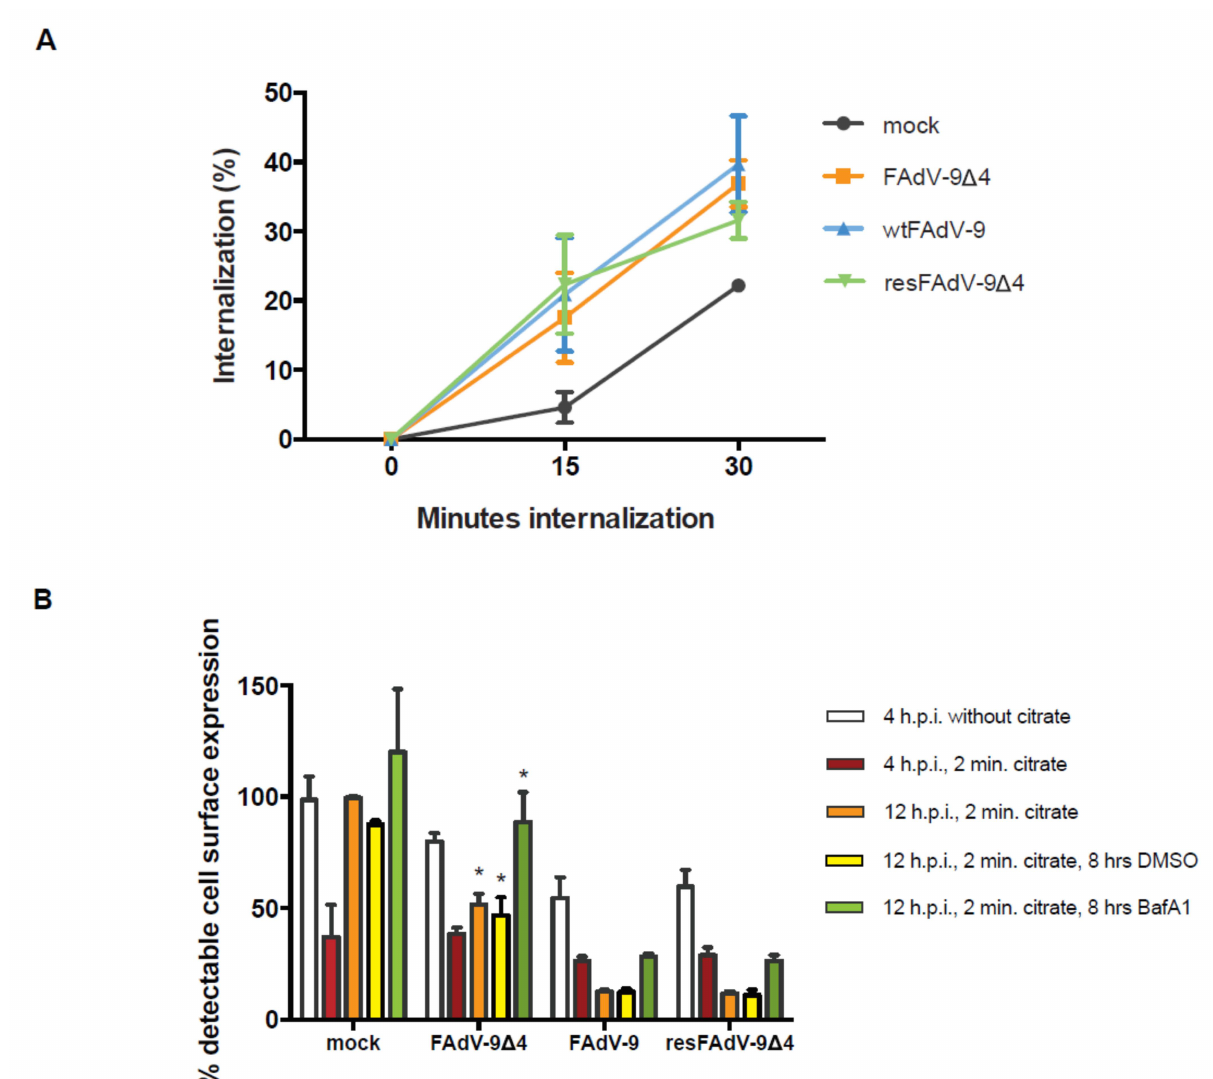
Figure 5. MHC-I internalization and the role of FE1 in appearance of MHC-I on the cell surface. ( A ) Assay for the extent of internalization of cell surface MHC-I. CH-SAH cells were either mock-infected or infected with FAdV-9 ∆ 4 (orange), FAdV-9 (blue), and resFAdV-9 ∆ 4 (green) at an MOI of 5. At 4 h.p.i., cells were incubated at 0 ◦ C with saturating concentrations of anti-MHC-I MAb F21/2 and then washed and incubated at 37 ◦ C for 15 or 30 min. The cells were then stained with FITC-conjugated goat anti-mouse IgG and analyzed by flow cytometry. Live cells were gated on the basis of propidium iodide staining. Background fluorescence was determined with an isotype control FITC-conjugated antibody for each treatment which was subtracted. The data points present averages and standard deviations of the means obtained from two independent experiments and are shown as percentage internalized relative to the initial MHC-I level at 4 h.p.i. (i.e. mean fluorescence following 30 min internalization for mock-infected cells minus mean fluorescence at 4 h.p.i for mock infected cells) ( B ) Restoration of cell-surface MHC-I following citric acid treatment. CH-SAH cells were either mock-infected or infected with FAdV-9 ∆ 4, FAdV-9, and resFAdV-9 ∆ 4 at an MOI of 5. Cells were then incubated at 37 ◦ C until 4 h.p.i. when live cells were left untreated or treated with ice-cold citrate buffer for 2 min. The acid solution was then neutralized and the cells were incubated at 37 ◦ C with or without DMSO solvent control or 0.1 µ M Bafilomycin A1 for the times indicated (0.8 h re-expression). The cells were then stained with anti-MHC-I MAb F21/2 followed by FITC-conjugated goat anti-mouse IgG. Live cells were gated on the basis of PI staining. Background fluorescence was determined with an isotype control means obtained from two independent experiments and are shown as percentages relative to initial mock expression prior to citrate treatment. An asterisk (*) indicates a significant difference ( p < 0.05) by Student’s T test in comparison to the corresponding treatment of the FAdV-9 and resFAdV-9 ∆ 4-infected